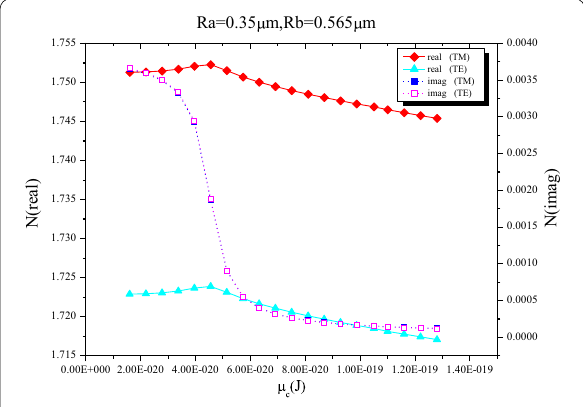
Fig. 5 Illustration of the real and imaginary parts of EMI for both TE and TM modes as a function of chemical